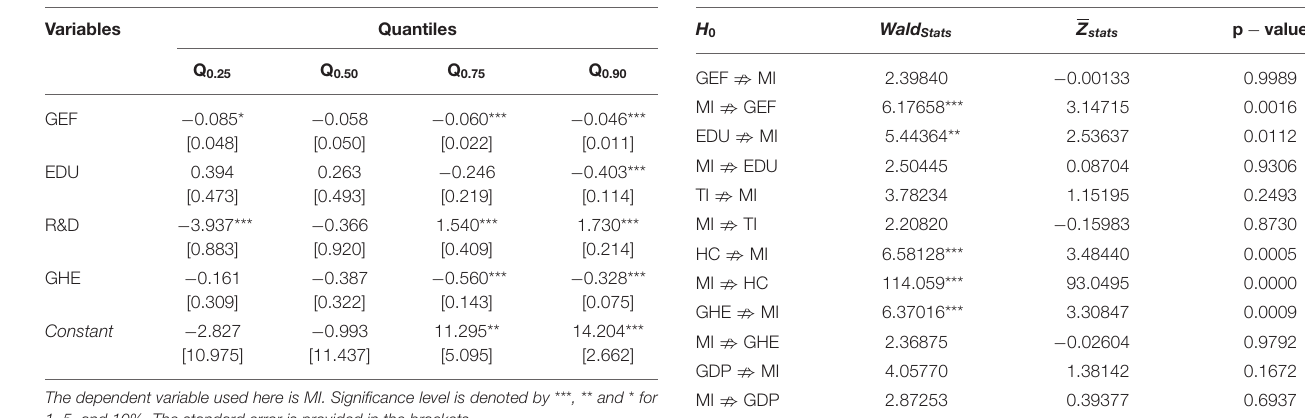
TABLE 10 | Dumitrescu–Hurlin panel